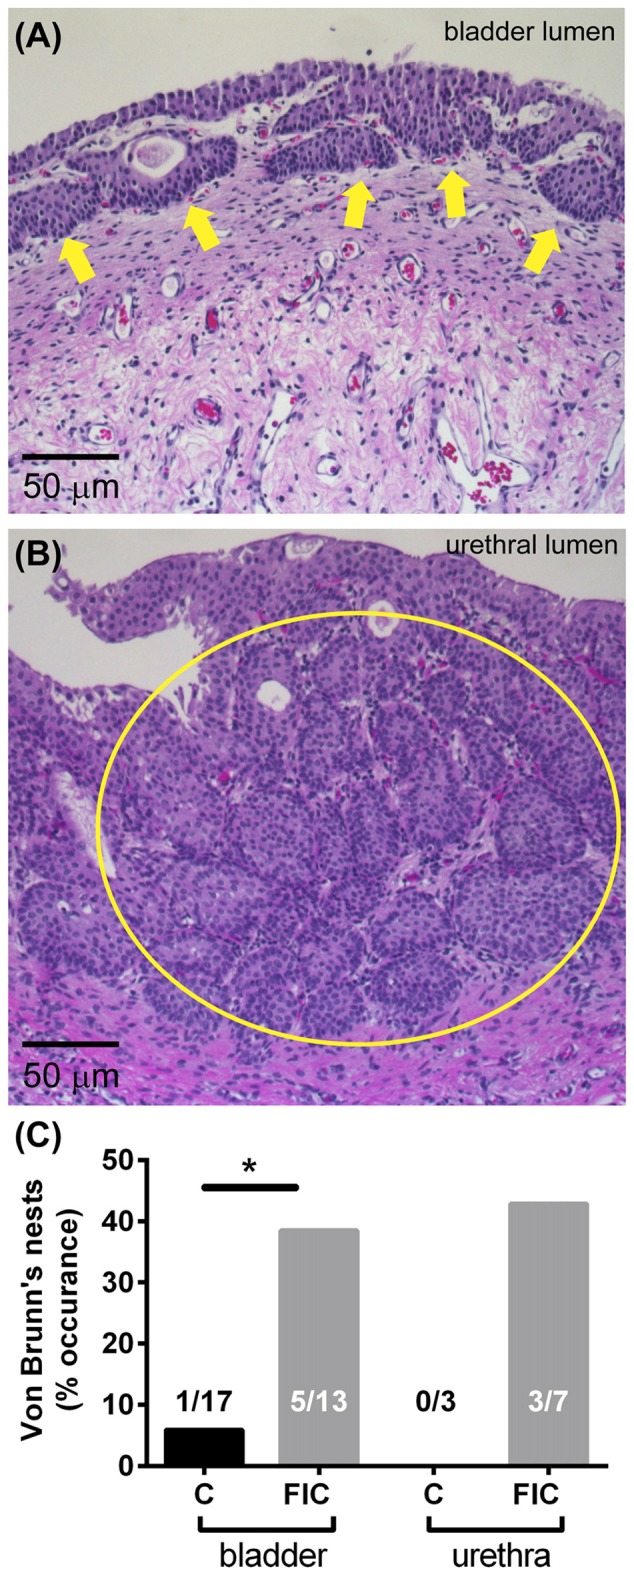
Von Brunn’s nests in the bladder and urethra. (A) Example of von Brunn’s nests indicated by yellow arrows, in the bladder of an FIC cat. (B) Example of von Brunn’s nests (inside the yellow circle) in the urethra of a FIC cat. (C) Percentage of control (black) and FIC (gray) cats presenting von Brunn’s nests in the bladder and urethra. Numbers on bar graphs represent the number of cats exhibiting von Brunn’s nests and the total number of cats assessed. Statistical significance was tested using Chi-square test: p = 0.02 for bladder and p = 0.17 for urethra. Asterisk (*) indicates p < 0.05.